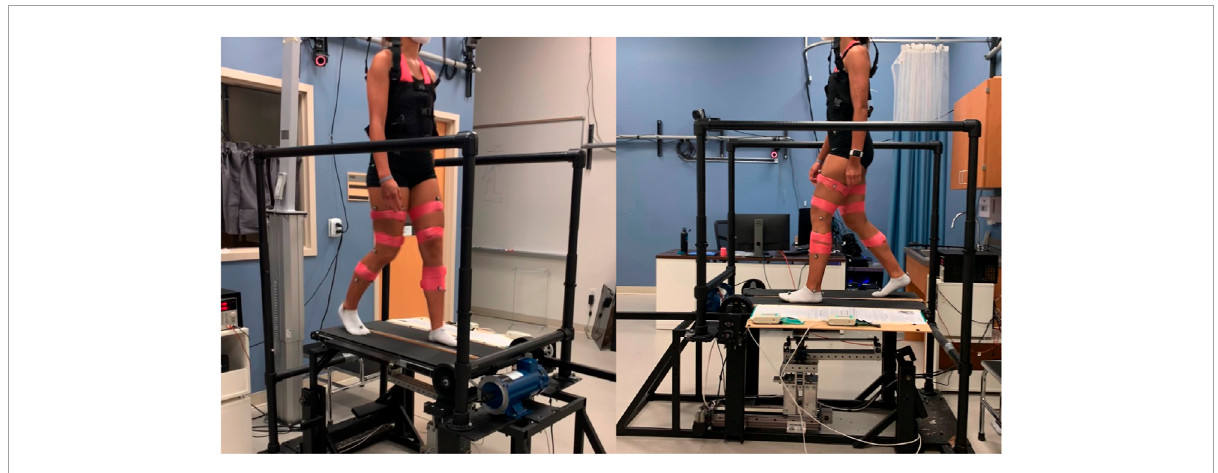
FIGURE 1 Subject walking on the VST with both belts set to rigid. Reflective markers and EMGs can be seen on the subject, as well as the safety harness.